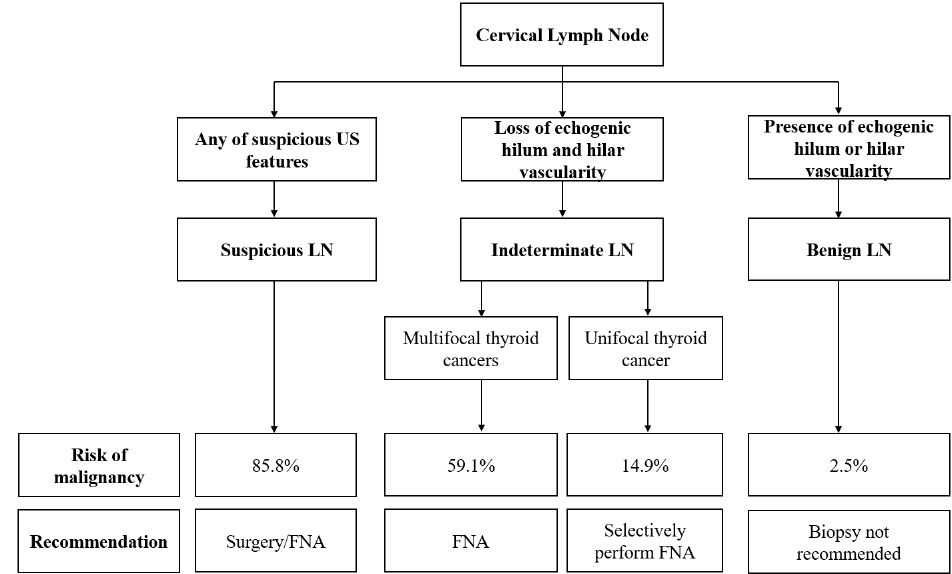
Figure 1. Diagram showing the algorithm for the diagnosis and management of cervical LNs in patients with thyroid cancer. LN, lymph node; FNA, fine-needle aspiration.